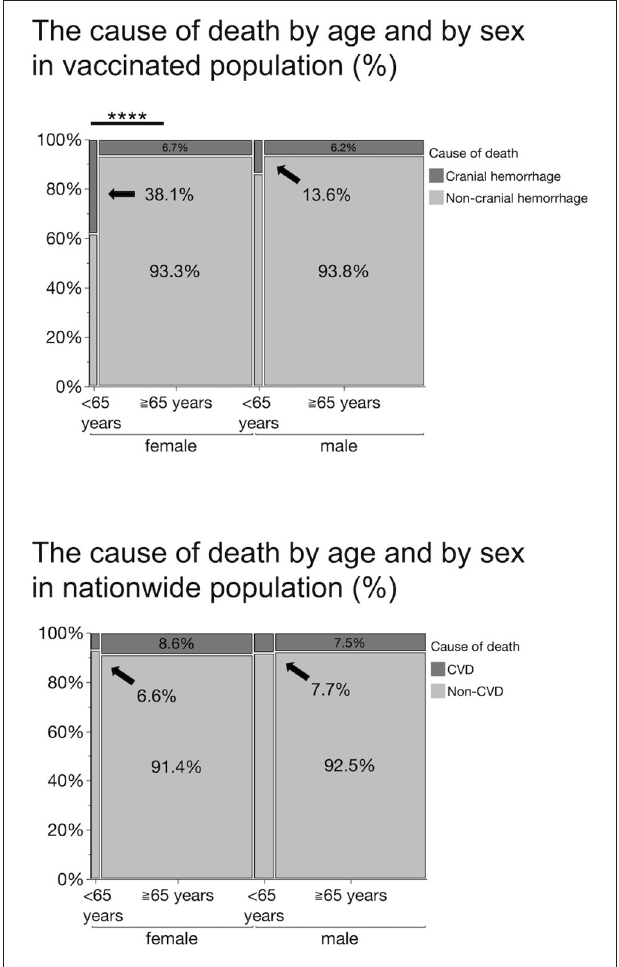
FIGURE 2 | Percentage of the cause of death by age and sex in vaccinated population and in a nationwide population in 2018. Cranial hemorrhages include subdural, subarachnoid, thalamic, cerebellar, brainstem, and cerebral hemorrhages. Cerebrovascular diseases (CVDs) include subarachnoid and intracerebral hemorrhage, cerebral infarction, and other cerebrovascular diseases. The frequency of death by cranial hemorrhage in vaccinated young women (38.1%) is significantly higher than that in the elderly women (6.7%), **** P < 0.0001 (*Pearson’s chi squared